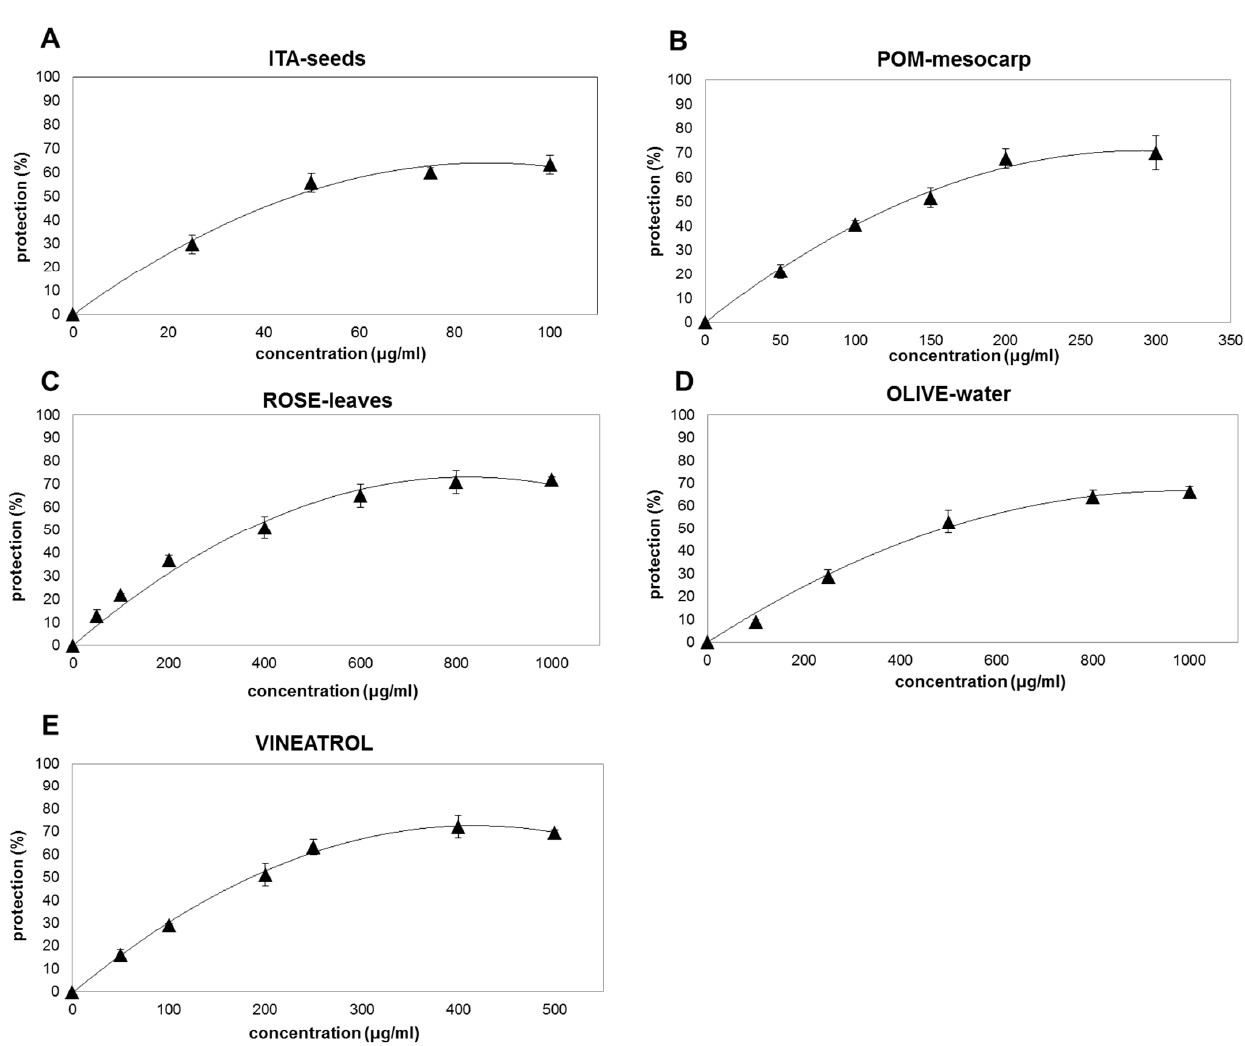
Figure 2. Protective effect of extracts from plant food-derived matrices and a commercial supplement on RBC membrane oxidation by UV-B radiation. The protective effects of different phenolic plant extracts (ITA-seeds ( A ); POM-mesocarp ( B ); ROSE-leaves ( C ); OLIVE-water ( D ); VINEATROL ( E )) are expressed as percentage inhibition of MDA formation induced by UV irradiation in the RBC membranes pre-incubation with different concentration of the antioxidants in comparison with the MDA produced by the same RBC membrane in absence of the same antioxidant mixes or purified molecules. The concentration of the antioxidants was increased until reaching a plateau indicating that saturation in the protective efficiency has been reached. The values are the means of three independent experiments ±